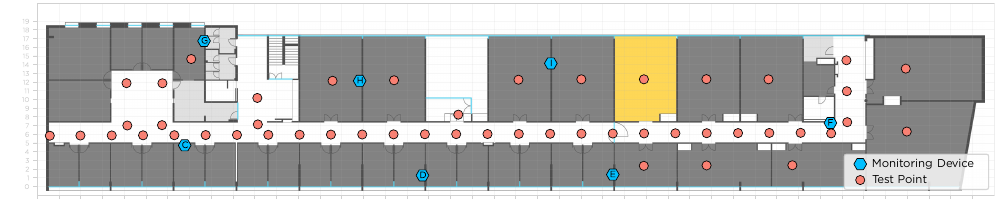
Figure 1. Floor plan of the building, including the positions of the Monitoring Devices and the site survey Reference Points.